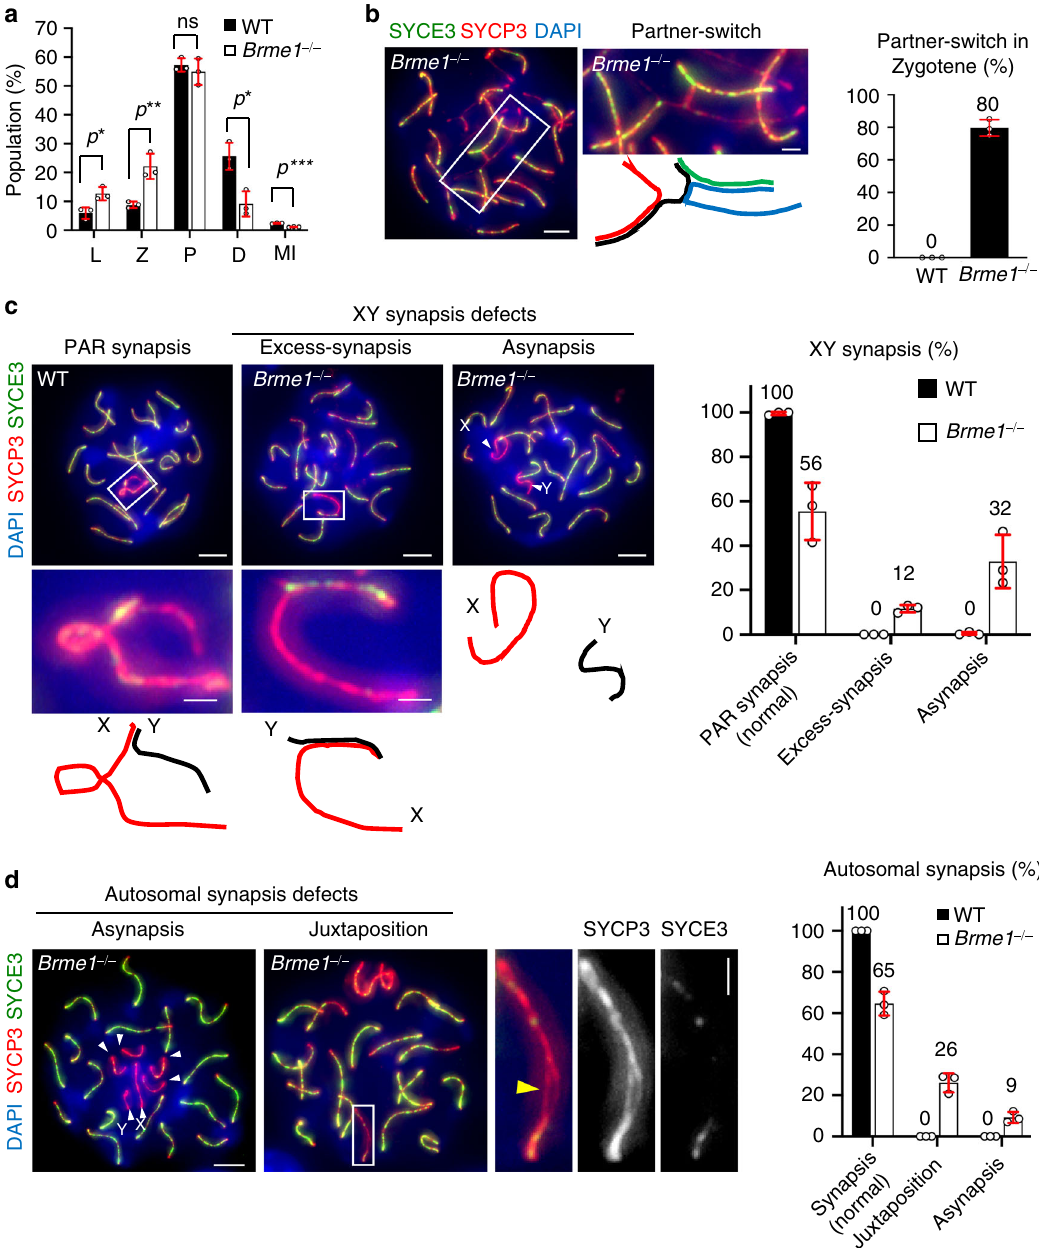
Fig. 6 Synapsis defects in Brme1 − ⁄ − spermatocytes. a Population of meiotic substages in WT (2623 cells) and Brme1 − ⁄ − (2565 cells) pooled from three mice for each genotype. The mean values of three independent experiments from three different mice are shown. Leptotene (L), zygotene (Z), pachytene (P), diplotene (D), metaphase I (MI). Error bars: SD. b Immunostaining of Brme1 − ⁄ − zygotene spermatocytes. Magni fi ed pictures with schematics highlight the partner switch. Graph: the ratio of zygotene spermatocytes (74 cells pooled from three mice for each genotypes) showing at least one partner switch. The mean values of three independent experiments from three different mice are shown. Error bars: SD. Scale bars: 5 μ m or 1 μ m in the magni fi ed panel. c Immunostaining of pachytene spermatocytes. Magni fi ed pictures with schematics highlight the sex chromosomes. Arrowheads: sex chromosome asynapsis. Graph: the frequency of cells with sex chromosome synapsis defects in WT (191 cells) and Brme1 − ⁄ − (285 cells) pooled from three mice for each genotype. The mean values of three independent experiments from three different mice are shown. Error bars: SD. Scale bars: 5 μ m or 1 μ m in the magni fi ed panel. d Immunostaining of pachytene spermatocytes. Arrowheads: asynapsis. The magni fi ed picture highlights the incompletely synapsed autosomes (juxtaposition) with a gap between aligned homologs (yellow arrowhead). Graph: the frequency of autosomal synapsis defects in WT (192 cells) and Brme1 − ⁄ − (280 cells) pooled from three mice for each genotype. The mean values of three independent experiments from three different mice are shown. Error bars: SD. Scale bars: 5 μ m or 1 μ m in the magni fi ed panel. All analyses used two-tailed t tests. ns: not signi fi cant. * p < 0.05, ** p < 0.01, *** p < 0.001. Source data are provided as a Source Data fi